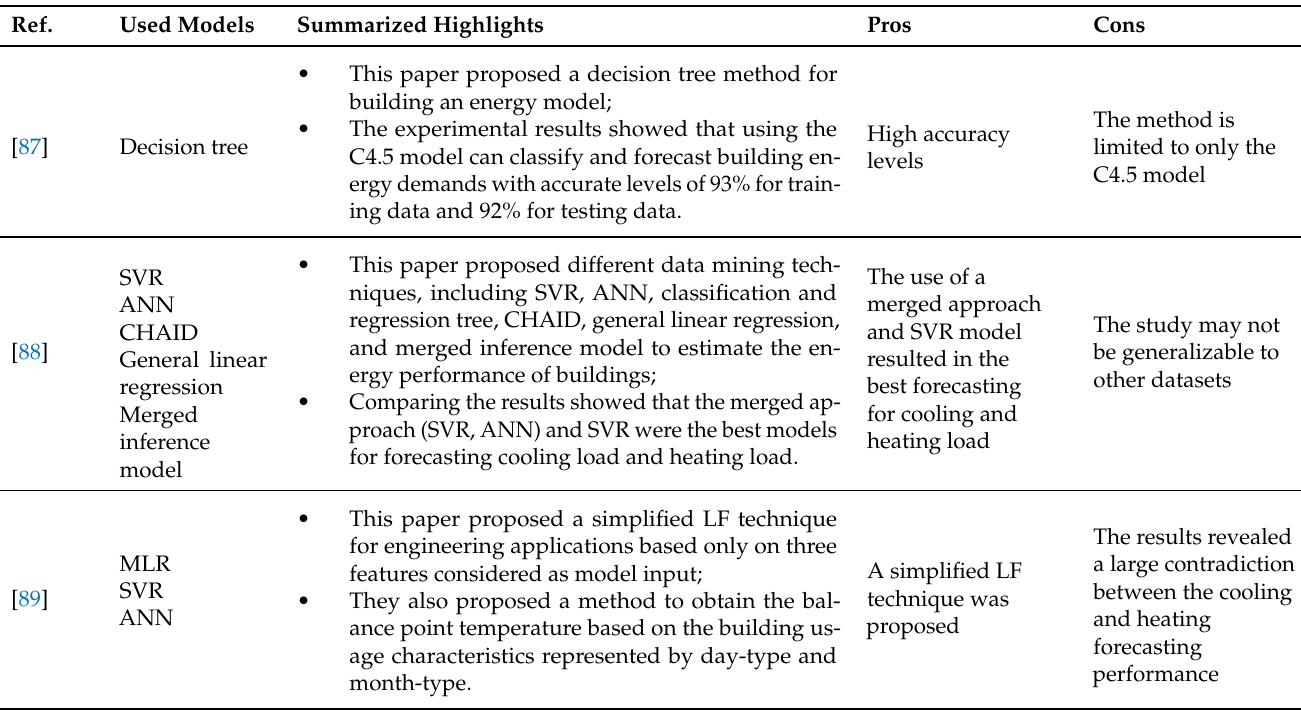
Table 4. AI-based load forecasting